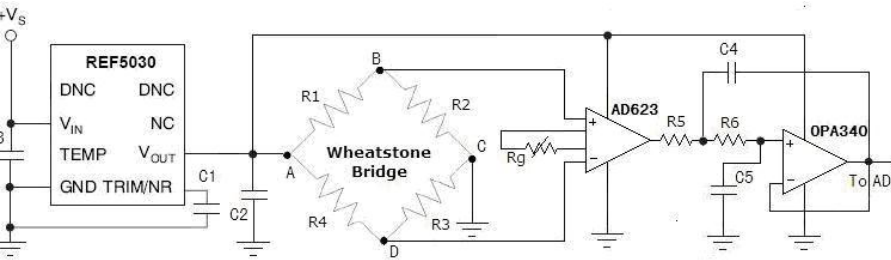
Figure 2. The schematic circuit diagram for high-precision strain measurements.